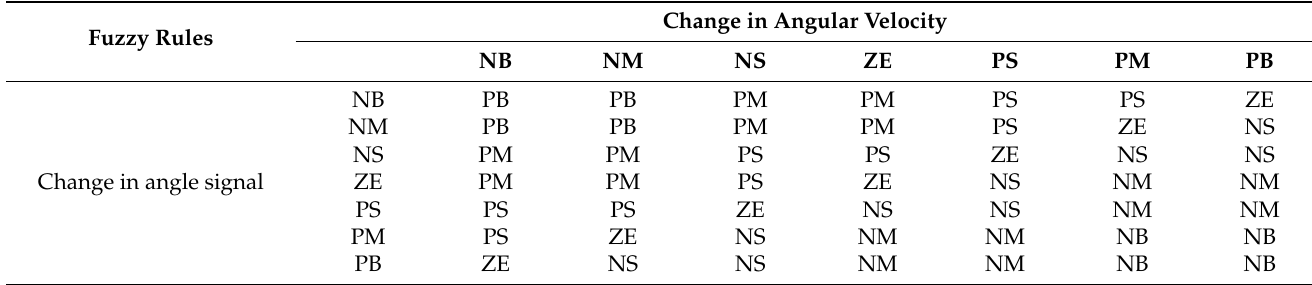
Table 3. Fuzzy control rules of PWM duty